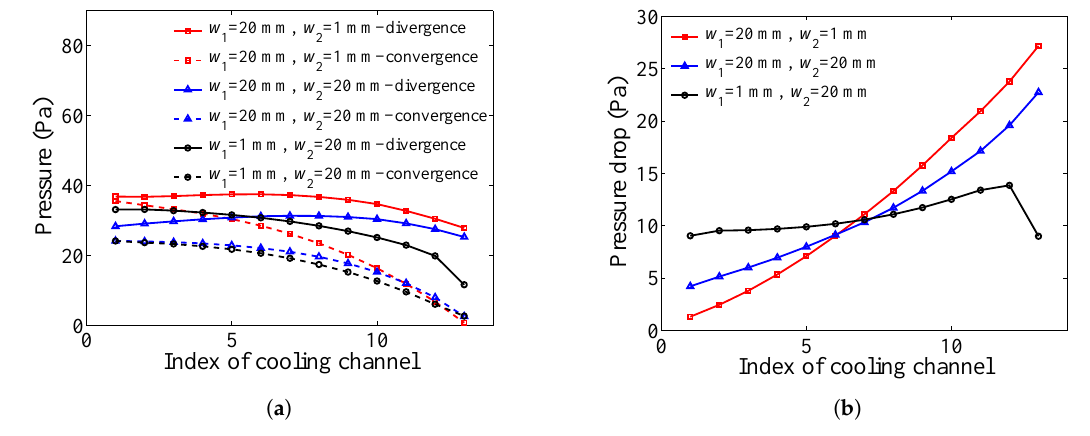
Figure 10. Comparison of numerical results for various angles of the plenums. ( a ) Pressure; ( b ) pressure drop.